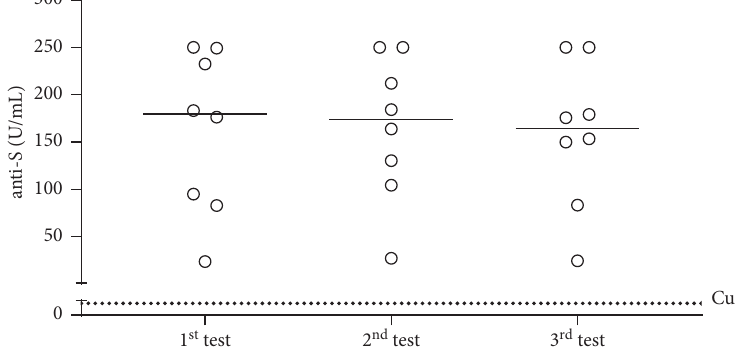
Figure 1: Serial measurement of anti-S antibodies’ response among infected HCWs after acquiring the first-dose inactivated SARS-CoV-2 vaccination. Antibodies against RBD of the S protein (anti-S) concentration among eight HCWs who get SARS-CoV-2 infection after receiving the first dose of the inactivated SARS-CoV-2 vaccination are shown. The anti-S antibody concentration was measured on days 30, 60, and 90 after the RT-PCR positive result. The black dotted horizontal line represents the cutoff value (0.8) suggested by the manufacturer for positive interpretation of antibodies to